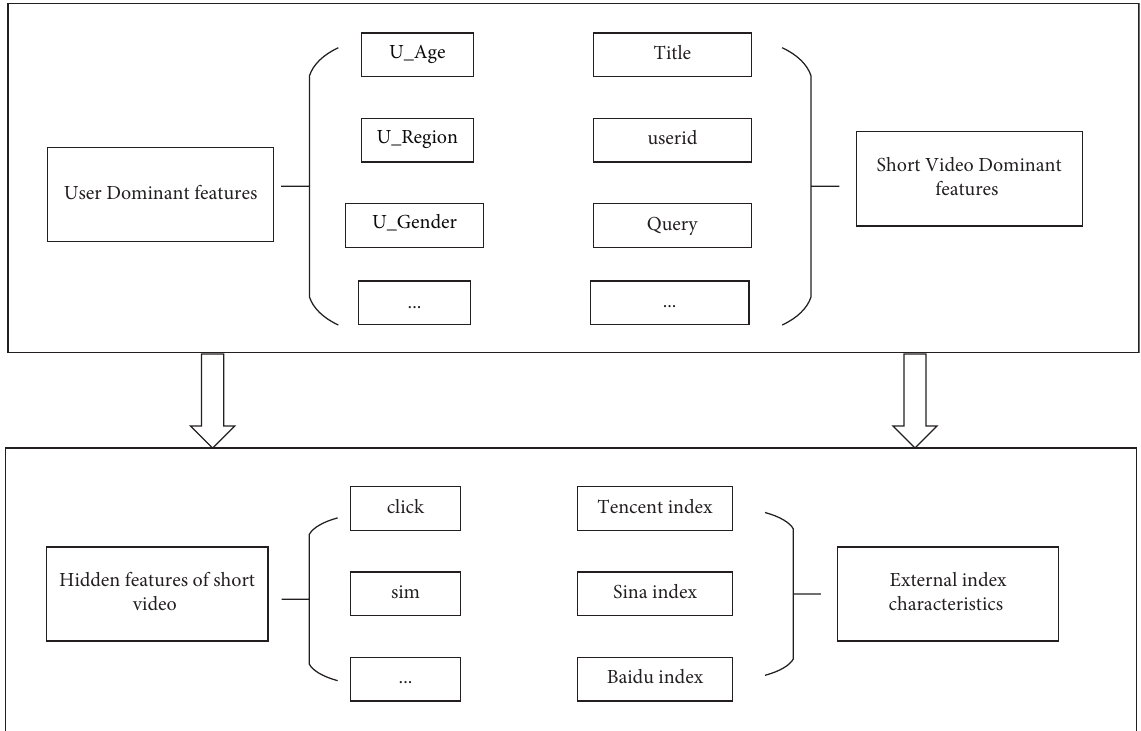
Figure 4: Short video